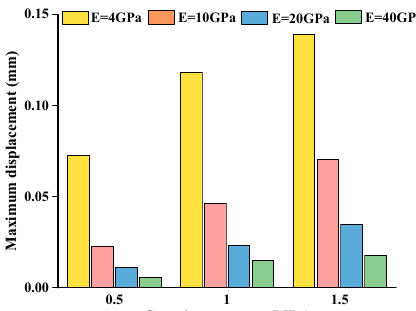
Figure 14. The grout diffusion length at different grouting pressures and different water–cement ratios (20 s).